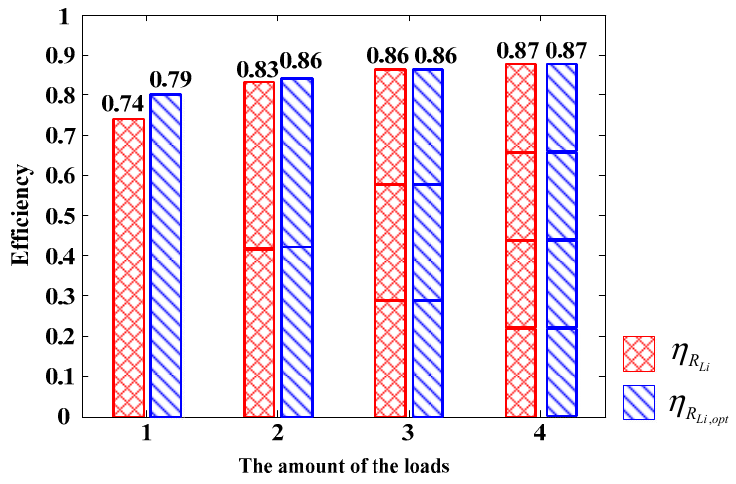
Figure 13. Comparison of system efficiency after efficiency optimization.